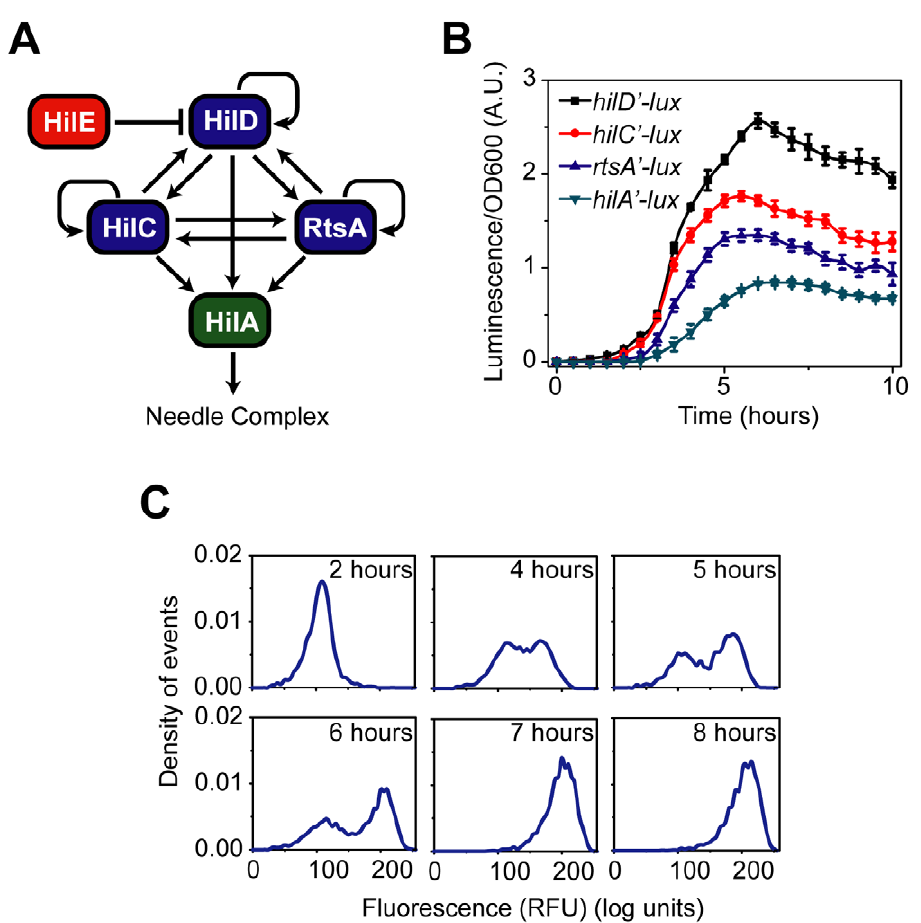
Figure 1. SPI1 gene expression is hierarchical and exhibits a switch-like transition from the ‘‘off’’ to the ‘‘on’’ state. (A) Diagram of the SPI1 gene circuit. HilA is the master SPI1 regulator as it activates the expression of the genes encoding the T3SS. HilA, in turn, is regulated by HilC, HilD, and RtsA. These three regulators can independently activate HilA expression. They can also activate their own expression and that of each other’s. HilE represses the activity of HilD by binding to it and preventing it from activating its target promoters. (B) Time-course dynamics of P hilD (pSS074), P hilC (pSS075), P rtsA (pSS076), and P hilA (pSS077) promoter activities in wild-type cells as determined using luciferase transcriptional reporters. To induce SPI1 gene expression, cells were first grown overnight in LB/no salt and then sub-cultured into fresh LB/1% NaCl conditions to an OD of 0.05 and grown statically. Luminescence values were normalized with the OD 600 absorbance to account for cell density. Average promoter activities from three independent experiments on separate days are reported. For each experiment, six samples were tested. Error-bars indicate standard deviation. (C) Dynamics of P hilA (pSS055) promoter activity in wild-type cells as determined using green fluorescent protein (GFP) transcriptional fusions and flow cytometry. The SPI1 gene expression was induced as described above. Samples were collected at the indicated times and arrested in their respective state by adding chloramphenicol. Approximately 30,000 cell measurements were used to construct each histogram. As a control, we expressed GFP from a constitutive promoter and observed continuous, rheostatic-like expression dynamics and a homogenous response in the population ( Figure S1E ). Strain genotypes and plasmid descriptions are provided in Tables 1 and 2 .